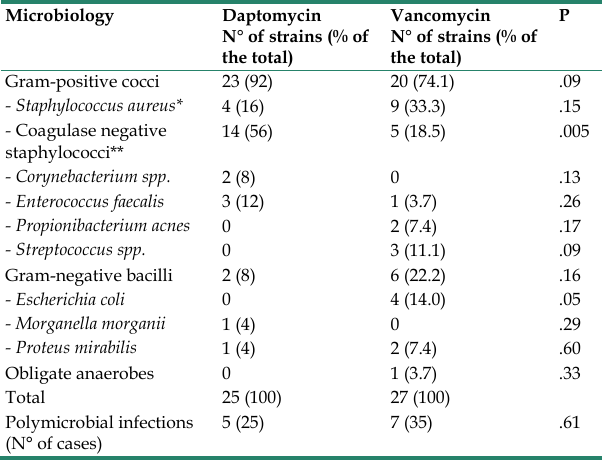
Table 2. Microbiological results of intraoperative samples culture in 40 patients treated empirically with either Daptomycin or